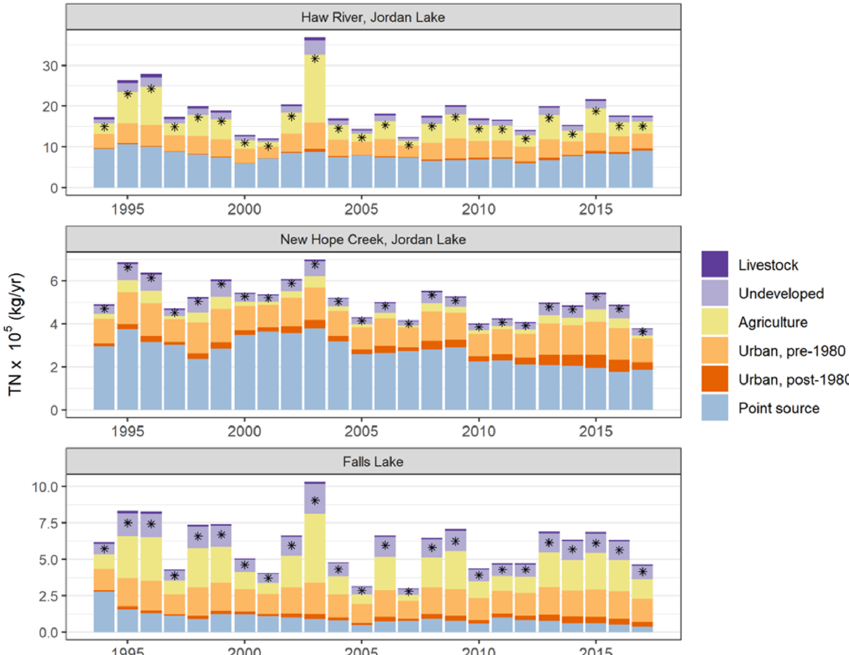
Figure 6. Total nitrogen export by year and major basin separated by source. The star ( ∗ ) represents the total TN load that reached Jordan or Falls